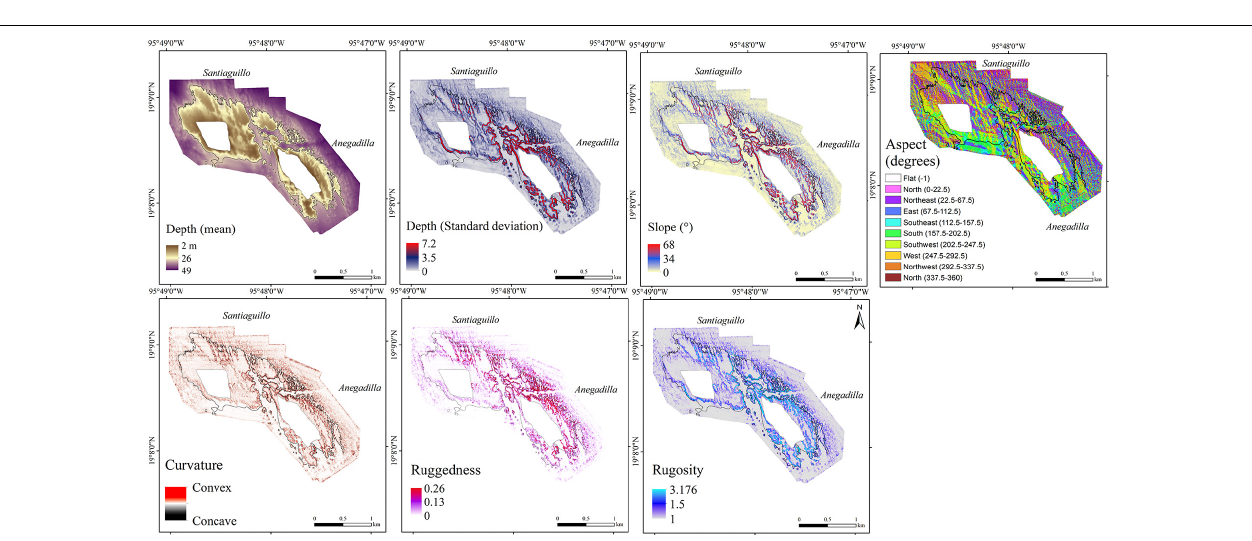
FIGURE 5 | Digital terrain models showing the result of the topographic variability analysis: mean depth, depth standard deviation, slope, aspect, curvature, ruggedness and rugosity for the SARC; 30 m isobath shown in black.